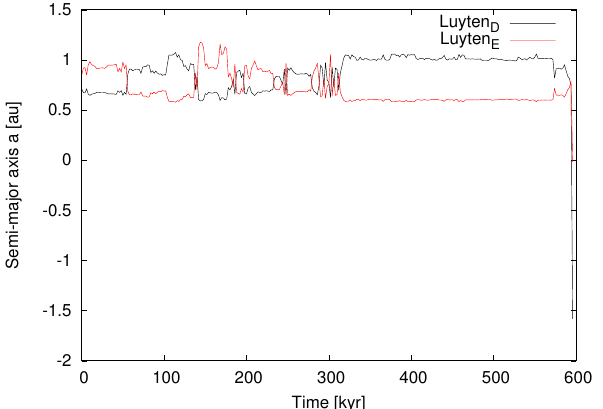
Figure 2. Case 1 ( e D = 0.085, e E = nominal). Time evolution of the two outer planets over 10 Myr. This is unstable configuration.